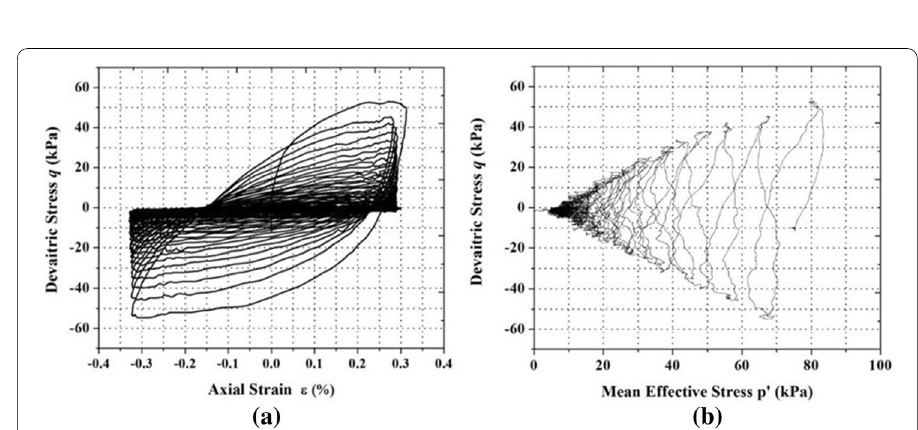
Fig. 6 a Stress strain relationship. b Stress path of Allahabad soil (RD 100 kPa, f 1 Hz, shear strain amplitude =